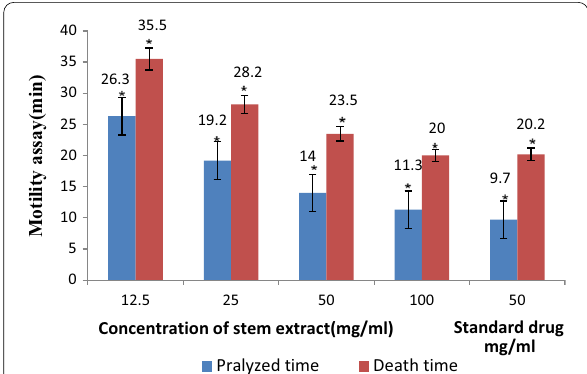
Fig. 2 Graphical presentation for anthelmintic activity of P. minima stem on the basis of paralysis time and death time on P. cervi in different concentration and it was compared with standard drug Albendazole. Less time was required for stem to cause paralysis and death (11.3 min and 20 min) of worms by an ethanolic extract (100 mg/ml). Data are expressed in mean SEM (* p < ±